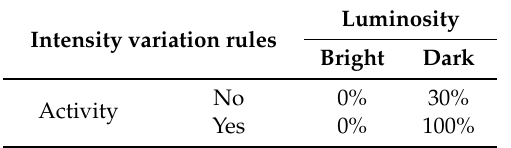
Table 1. Configuration of the intensity variation rule.